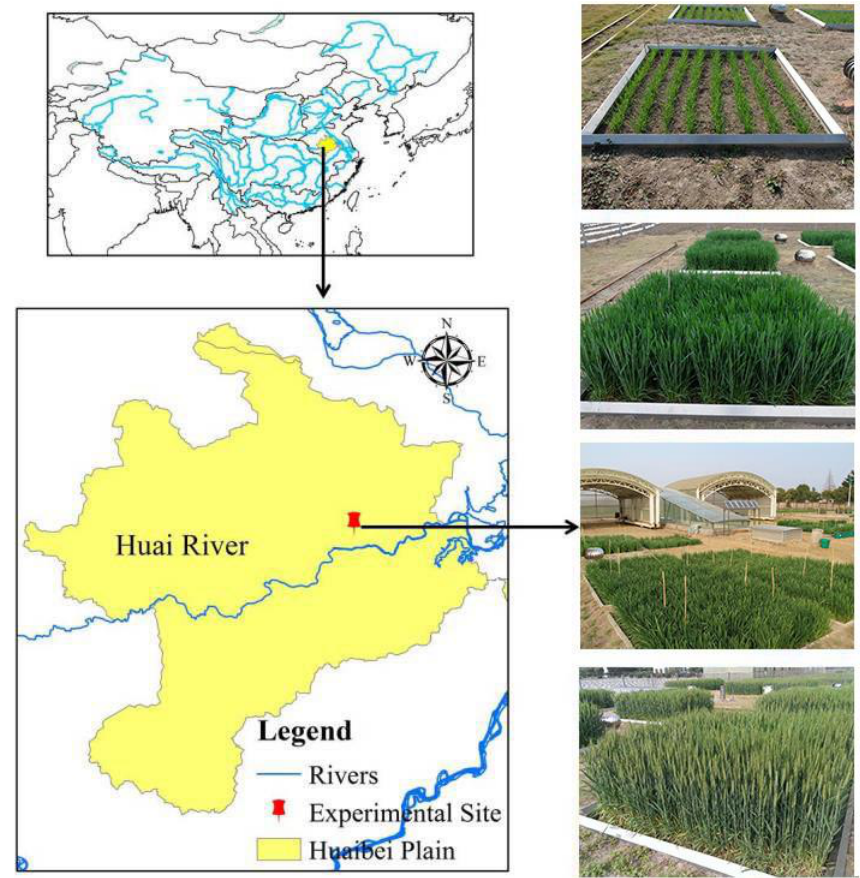
Figure 1. Location of the site in the Huaibei Plain and conditions of the winter wheat in plots.